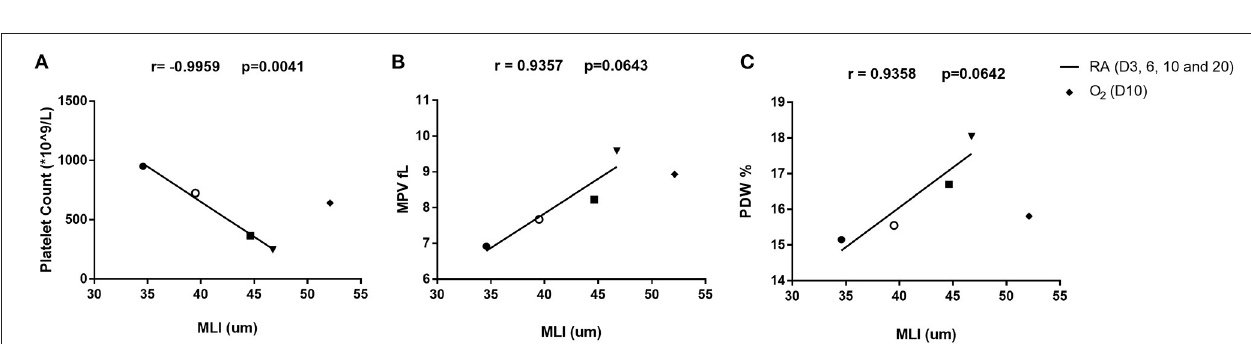
FIGURE 4 | Dynamic change of platelet parameters during lung alveolarization ( N = 8–10, A–C ), mean linear intercept (MLI, N = 3–5, D ) and representative photos during rats’ development (E–J) in normoxia. Values are expressed as mean ± SD. * p < 0.05, ** p < 0.01, *** p < 0.001, compared with adults using one-way ANOVA. Magnification, 200x.